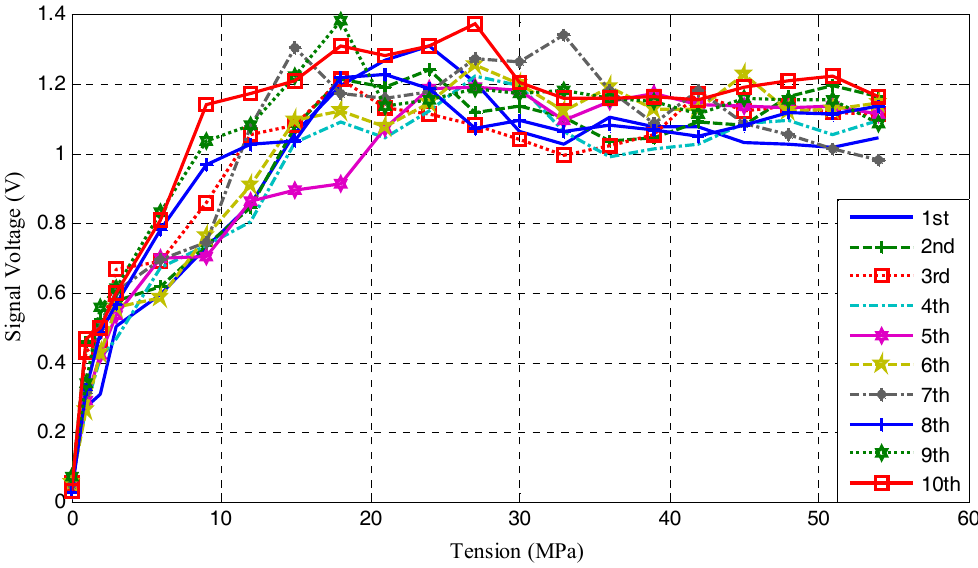
Figure 5. The signal voltages acquired from smart washer.